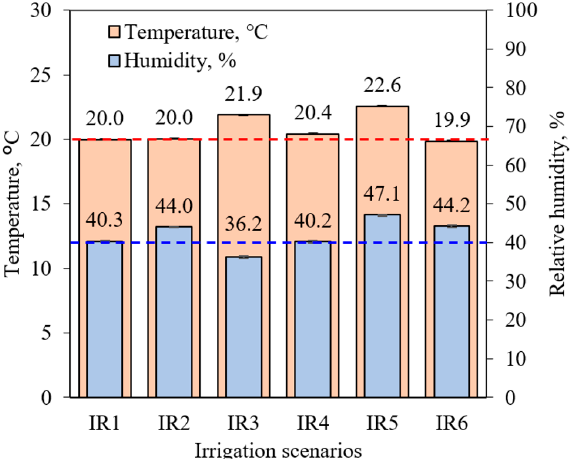
Figure 4. Temperatures and relative humidity over one growth cycle in each irrigation scenario. The red dashed line represents the set temperature value, and the blue one represents the humidity value.